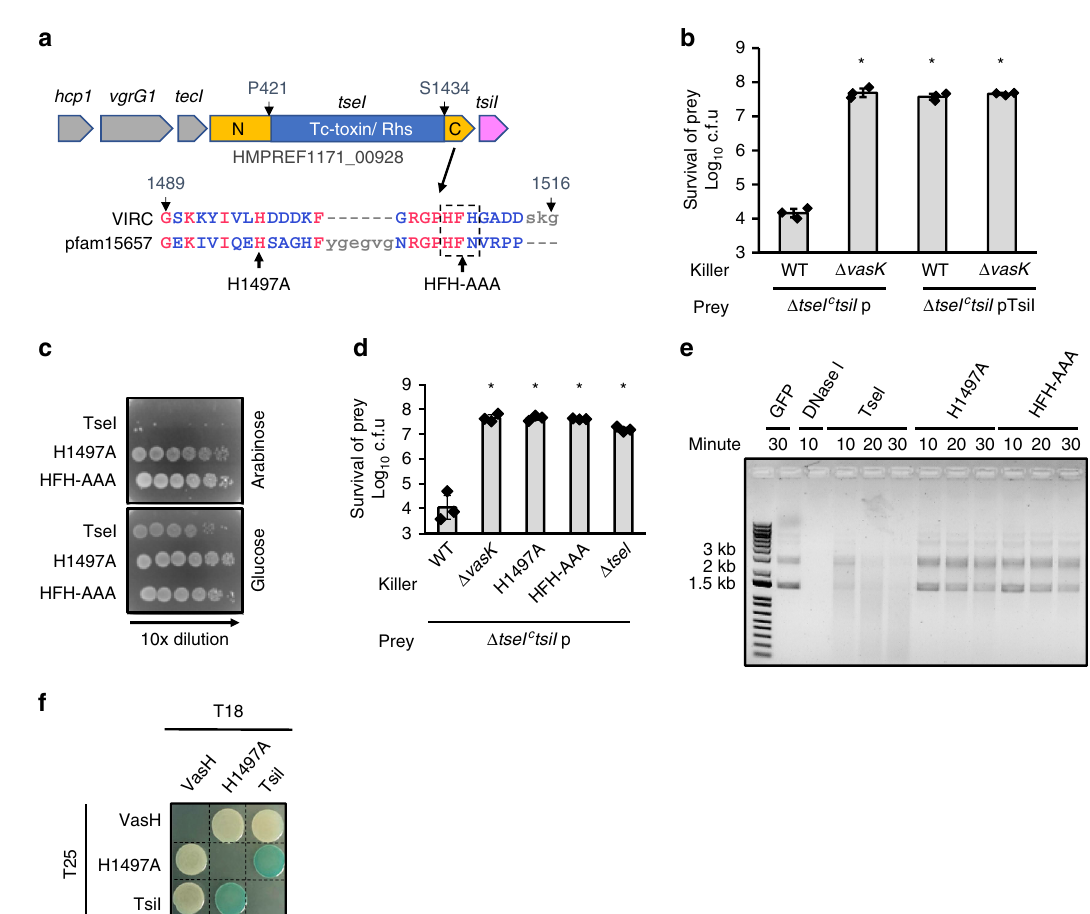
Fig. 1 Characterization of TseI – TsiI effector – immunity pair. a Operon structure and predicted catalytic residues of TseI. The TseI N-terminal domain VIRN and C-terminal VIRC domain are indicated as N and C for simplicity. The fi rst residues for the middle Rhs domain and for the VIRC are indicated. The immunity gene tsiI is not annotated in the draft genome. Sequence of the VIRC toxin region was aligned with the consensus sequence of Pfam15657 that represents a conserved domain family of the predicted HNH/Endonuclease VII toxin with a characteristic conserved [ED]H motif and two histidine residues. b Competition assay of wild type (WT) and the T6SS-null Δ vasK mutant against the effector – immunity deletion mutant Δ tseI c tsiI . Survival of Δ tseI c tsiI complemented with an empty vector (p) or a vector carrying the immunity gene tsiI was quanti fi ed after co-incubation with the killer strains. c Toxicity of expressing TseI and its catalytically inactive mutants in E. coli . TseI and its mutants were expressed on pBAD vectors and survival of E. coli was tested by serial plating on arabinose (induction) and glucose (repression) plates with 10-fold dilutions. Expression of wild type and mutant TseI was con fi rmed by western blot analysis shown in Supplementary Fig. 2A. d Competition assay showing the activity loss of TseI mutants. Survival of killer and prey strains that carry pBAD vectors with different antibiotic resistance was enumerated by serial plating on selective medium for the killer and the prey, respectively. Survival of the killer strains is shown in Supplementary Fig. 2B. e DNA degradation by TseI and its mutants. Puri fi ed pUC19 plasmid was treated with GFP, DNase I, TseI, and two TseI catalytic mutants. DNA was sampled at different time points and examined by electrophoresis on an agarose gel. For activity assays, TseI proteins were puri fi ed under denaturing conditions as described in Methods and quality checked by SDS-PAGE analysis in Supplementary Fig. 2C. Green fl uorescence proteins (GFP) was puri fi ed similarly except for without denaturing treatment and was used as a negative control. For each reaction, 0.3 μ g protein was used. Commercial DNase I (1 unit) was used as a positive control. f Bacterial two-hybrid analysis of TseI – TsiI interaction. Proteins fused with the adenylate cyclase T25 or T18 subunits were co-expressed in the reporter strain BTH101 as indicated. Positive interaction results in color development on an LB-X-gal plate. A known T6SS transcriptional regulator VasH was used as a negative control. For killing assays ( b , d ), error bars indicate the mean ± standard deviation of three biological replicates and statistical signi fi cance was calculated using a two-tailed Student ’ s t -test, * P < 0.01. Source data are provided as a Source Data fi le. Data in b – f are representative of at least two